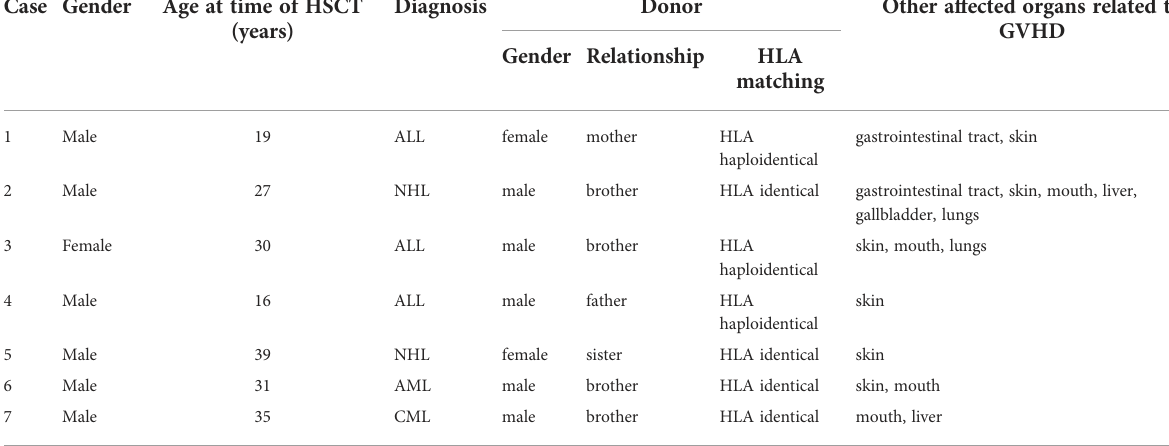
TABLE 1 Demographic and hematologic data of corneal perforation